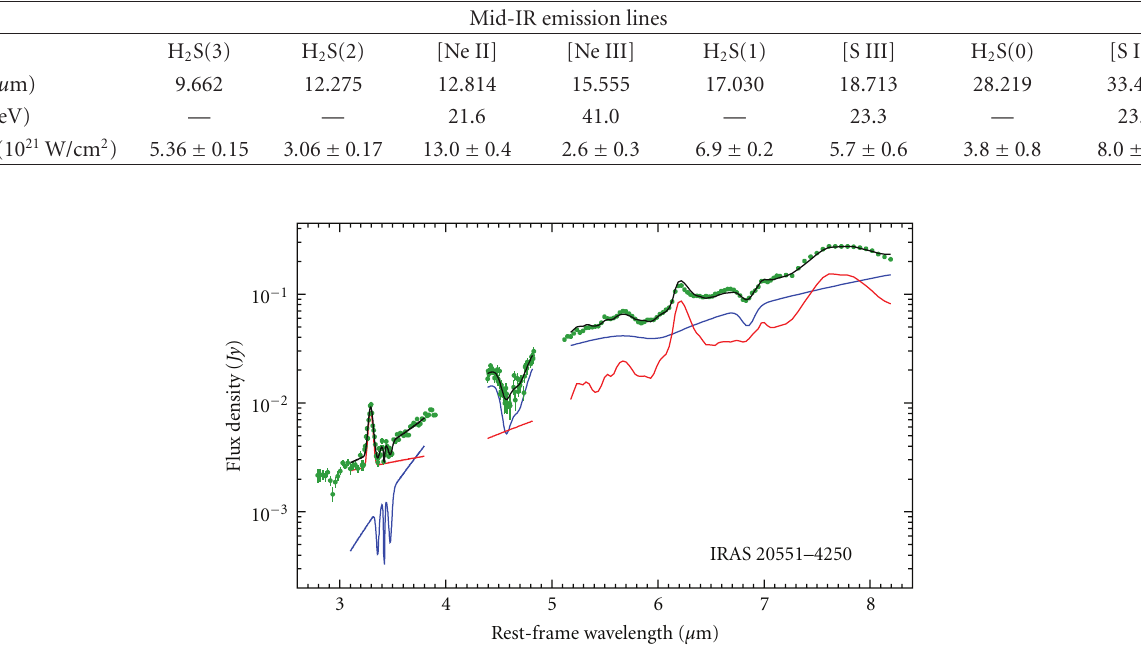
Figure 4: VLT /ISAAC L - and M -bands, plus Spitzer /IRS low-resolution spectra of IRAS 20551-4250. The data and best-fit models for each band are plotted in green and black, respectively. The di ff erent contributions to the observed spectra (blue for AGN component, red for the SB one) are also shown. Absorption features are fitted separately and then combined with the AGN template. Due to the strong reddening of the AGN continuum, the only AGN signature within the L -band is the shallow, structured 3.4 μ m hydrocarbon absorption, highly diluted by the SB emission. The M -band continuum cannot be constrained due to the deep CO features, while the 6.0 μ m water ice and 6.85 μ m hydrocarbon absorption profiles are detected at 5–8 μ m [9,